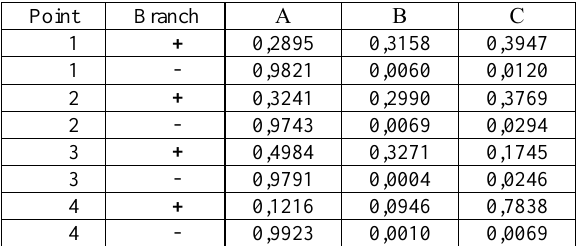
Table 2. The coefficients of the approximation curve for the points along the edge of the step. Sign of the branches corresponds to the sign of the probe potential